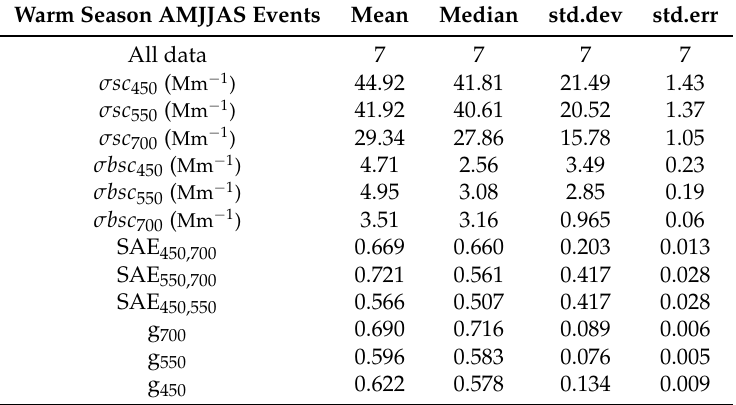
Table 8. Statistics ( σ sc , σ bsc , SAE, g), at LMT Observatory, all selected dust events in warm season.